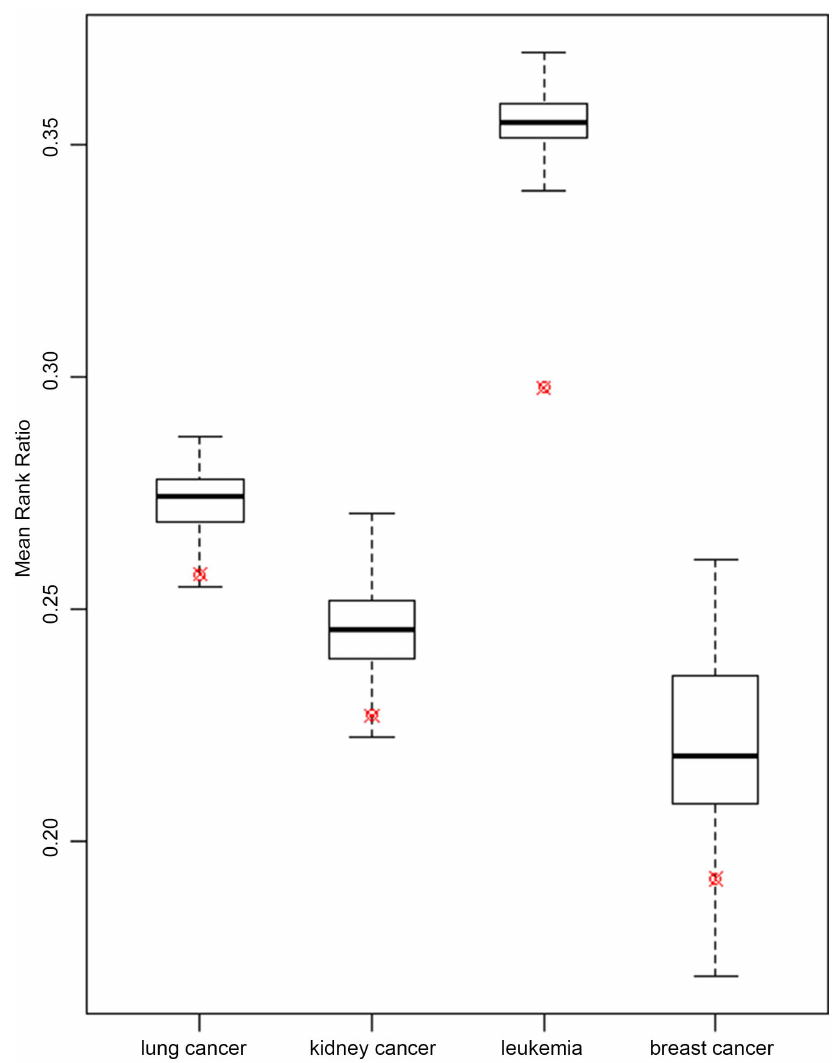
Figure 4. MRR Comparisons of GroupRank using co-expressed and random groups. The red sign represents MRR of GroupRank using co- expressed gene groups in four cancers. Boxplots show the distributions of MRRs using random groups of the same size. The random sampling was repeated 1000 times in each cancer type.